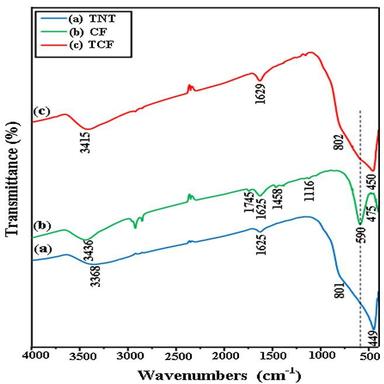
FT-IR spectra of the prepared photocatalytic materials.